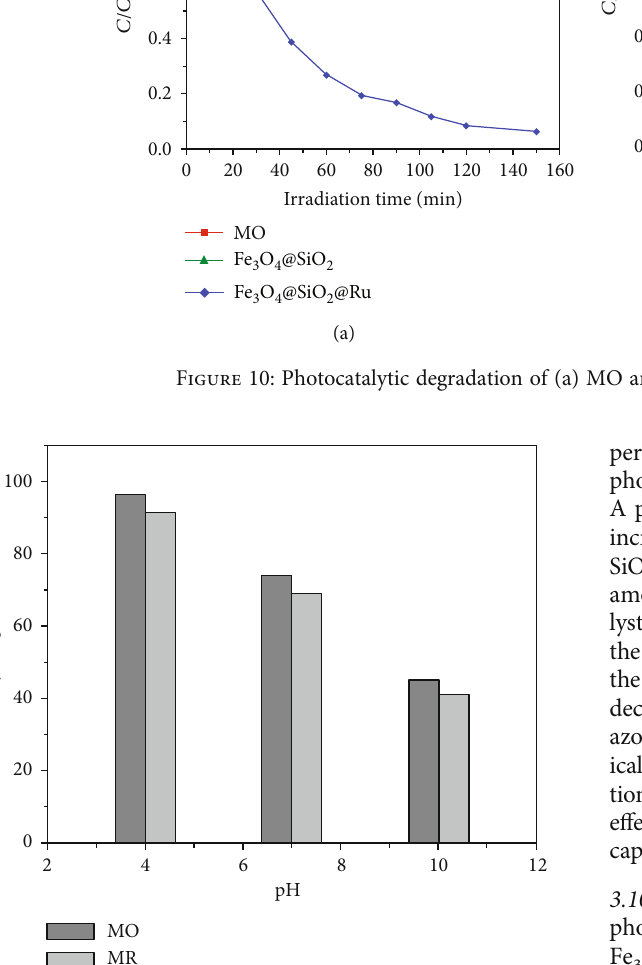
Figure 11: E ff ect of pH on the degradation of MO and